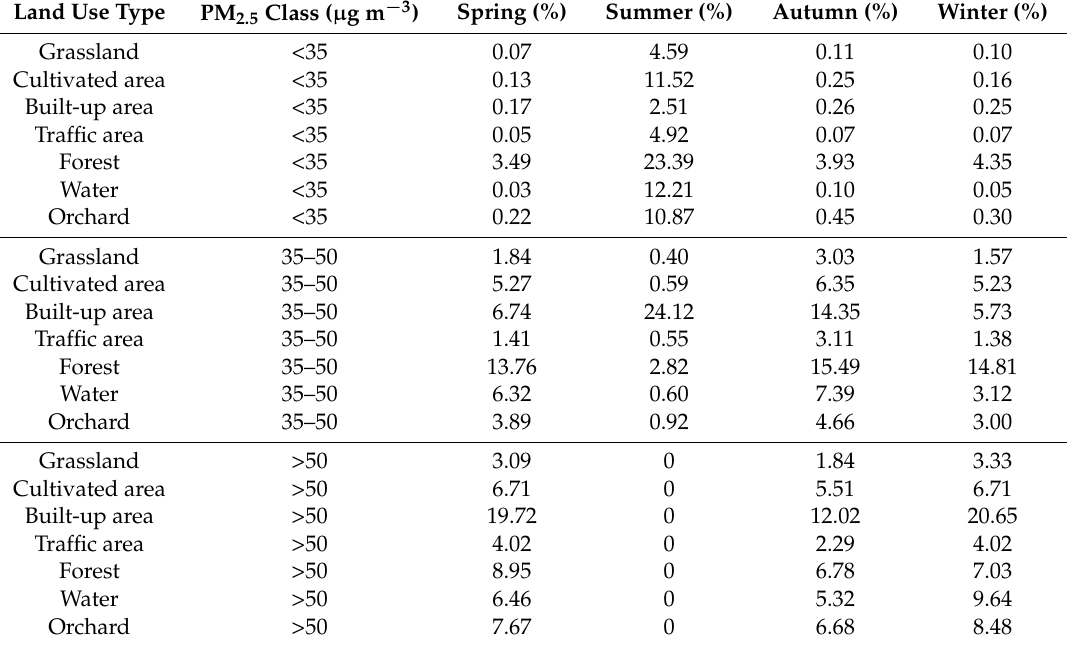
Table 3. The percentage area of the different land use types to the total study area percentage (%) by the three levels of PM 2.5 concentration in the four